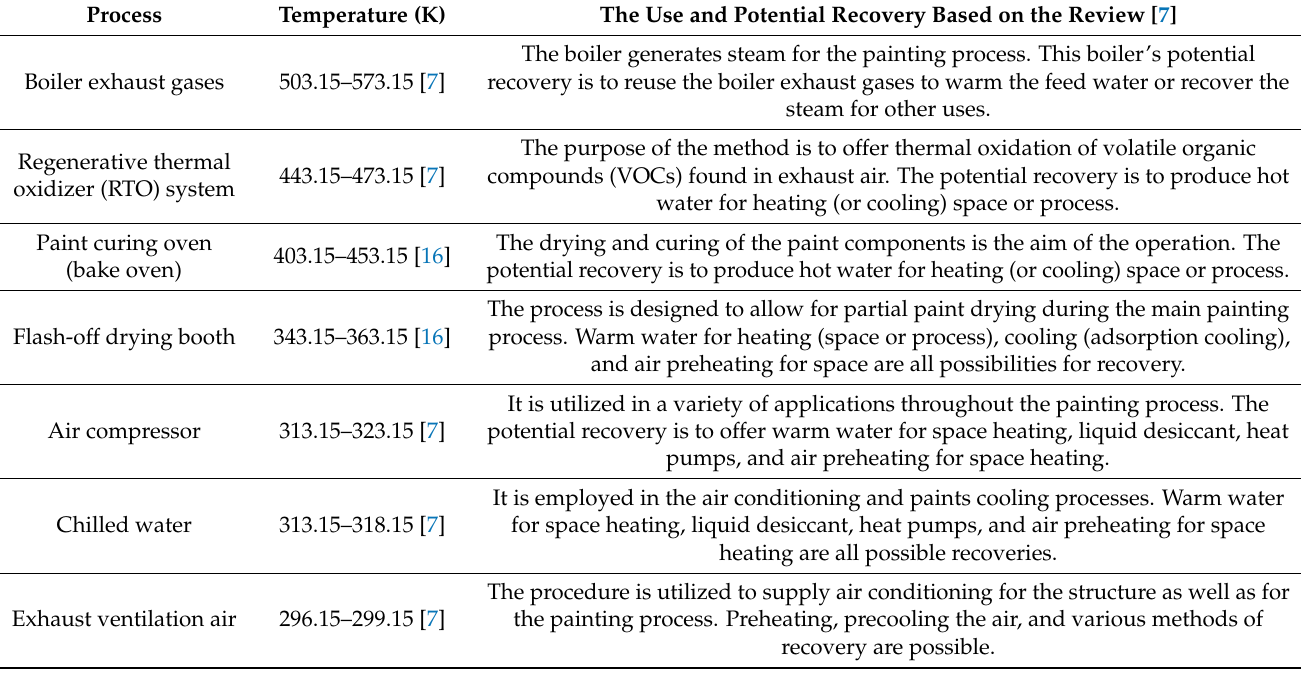
Table 4. Potential waste heat sources in the paint